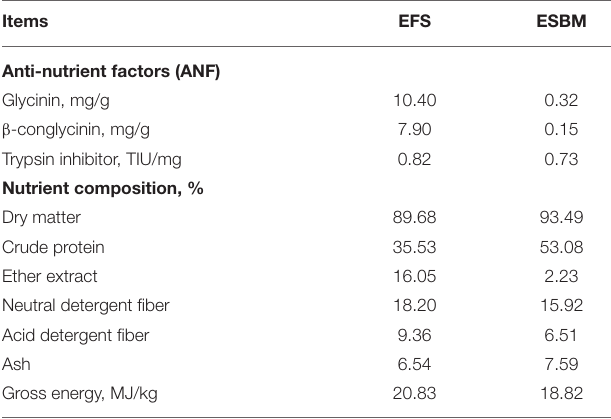
TABLE 1 | Anti-nutrient factors and nutrient composition in extruded and enzyme-treated soybean meal (%, as-fed